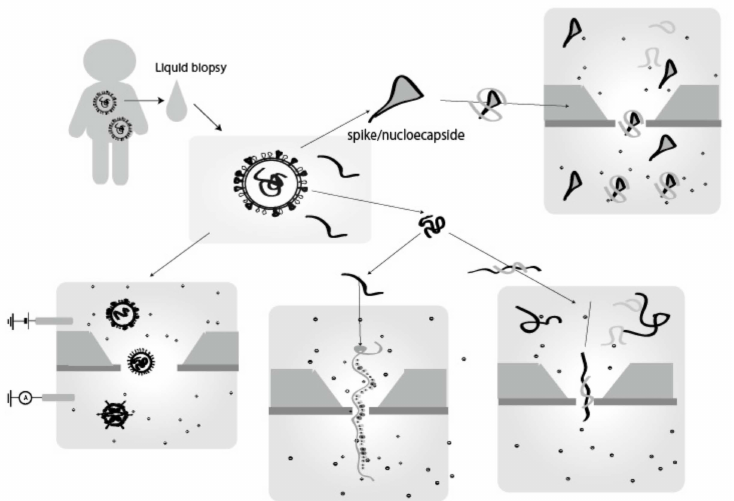
Figure 5. Virus detection by single-molecule/particle electrical detection with a nanopore device. Sample viruses are collected from liquid biopsy samples, such as nasal swabs, saliva, blood, and urine, etc. As targets, there are virus whole-particles, RNA and/or its cDNA converted from the virus RNA, and parts of the virus particles and its proteins such as spikes that constitute the virus. The presence of viruses has been detected by identifying the shape of the virus, sequencing nucleic acid base chains, detecting known target nucleic acid base sequences by complementary strand sequences, and detecting target markers such as proteins by using probe molecules that selectively bind to